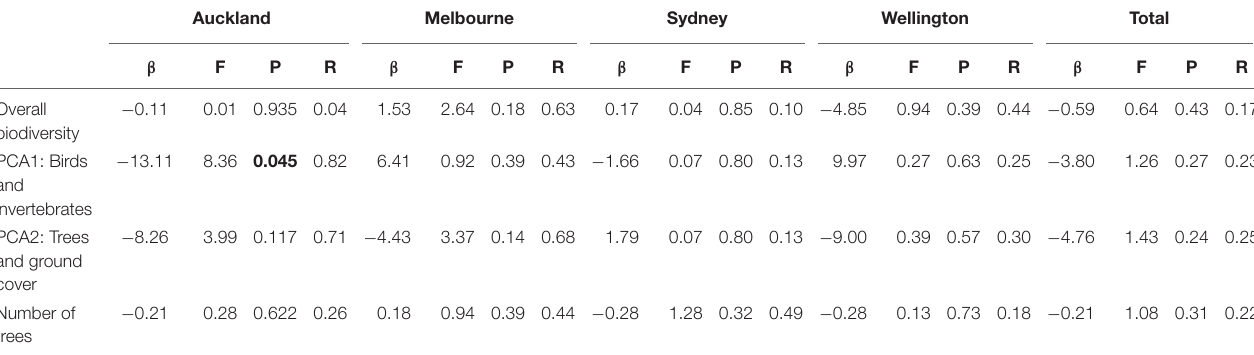
TABLE 2 | We tested for relationships between the number of people present in parks with the biodiversity (number of species), two principal components (birds and invertebrates, trees and ground cover), and the number of trees and found no consistent